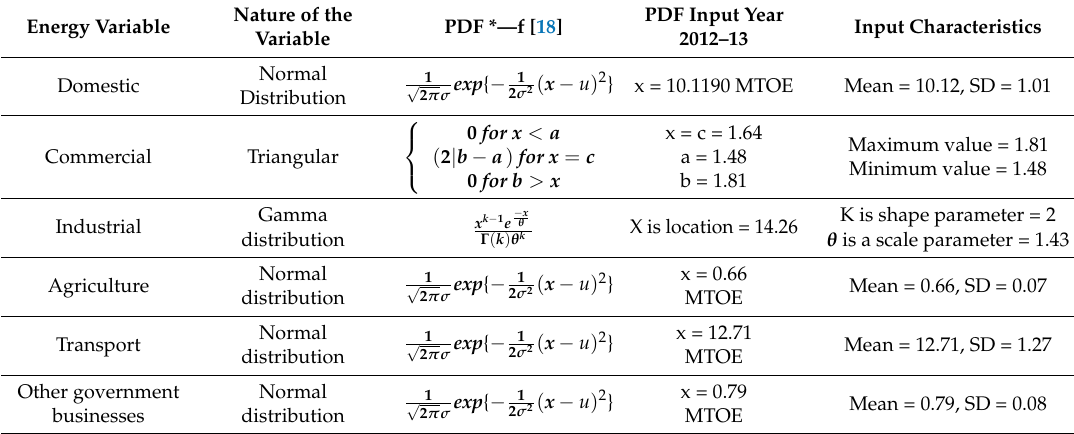
Table 1. Energy variables and characteristics of their probability density functions